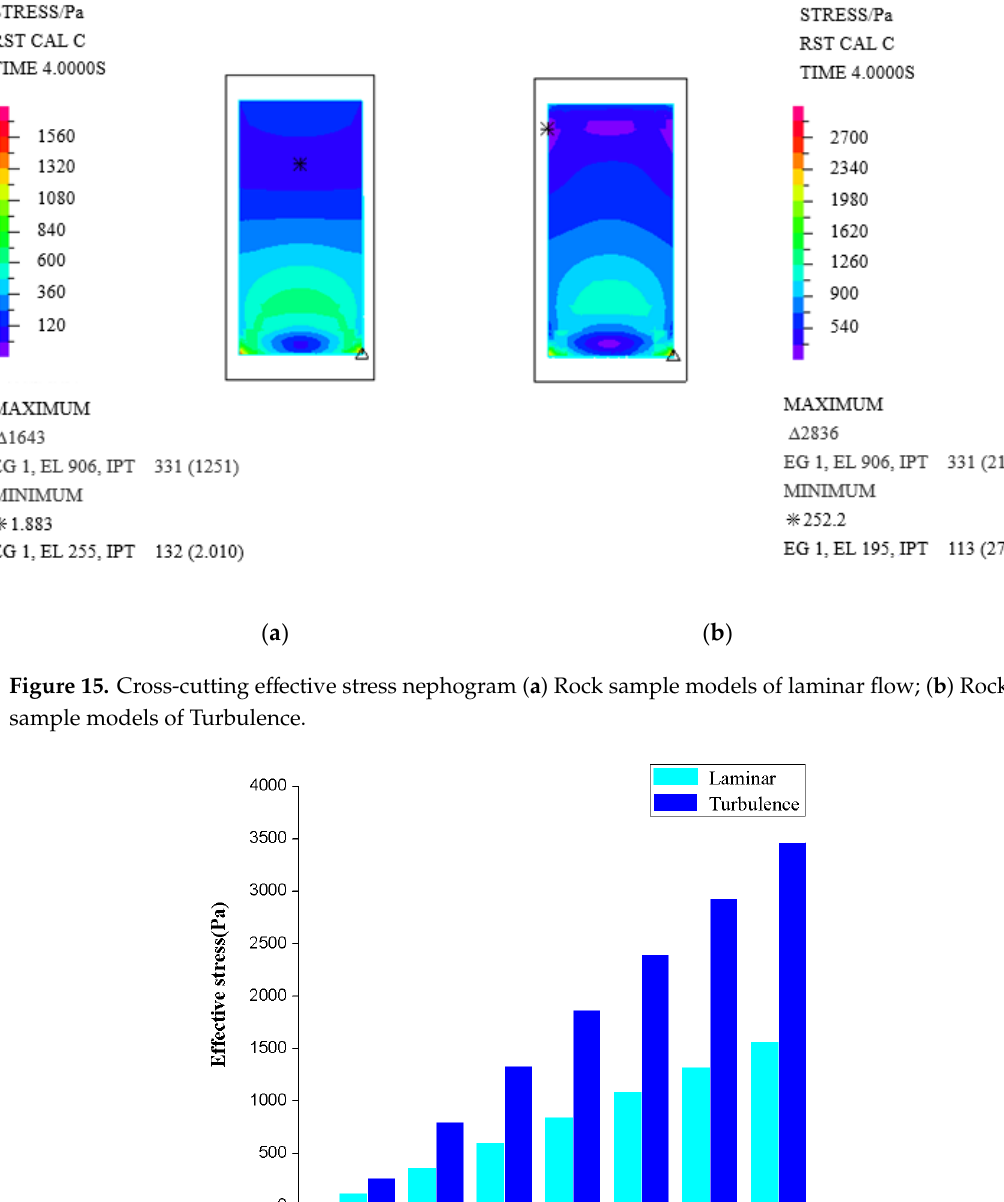
Figure 16. Laminar and turbulence rock sample models mark points of slitting line effective stress nephogram.